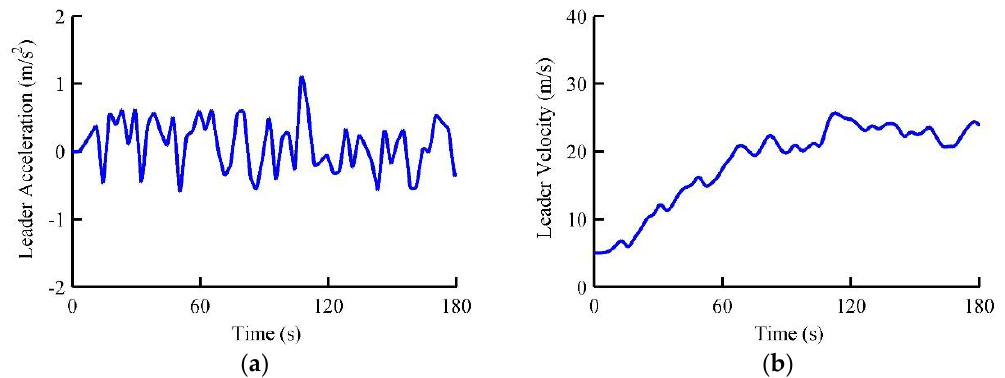
Figure 5. Profiles of leader state. ( a ) Leader Acceleration. ( b ) Leader velocity.